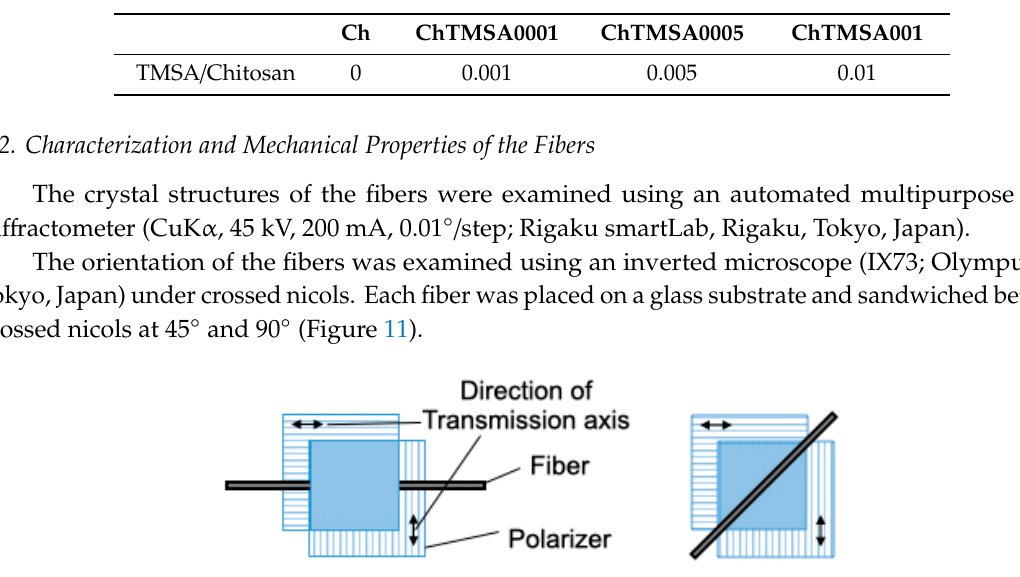
Table 3. Starting composition (molar ratio) of the fibers and sample code of each fiber.